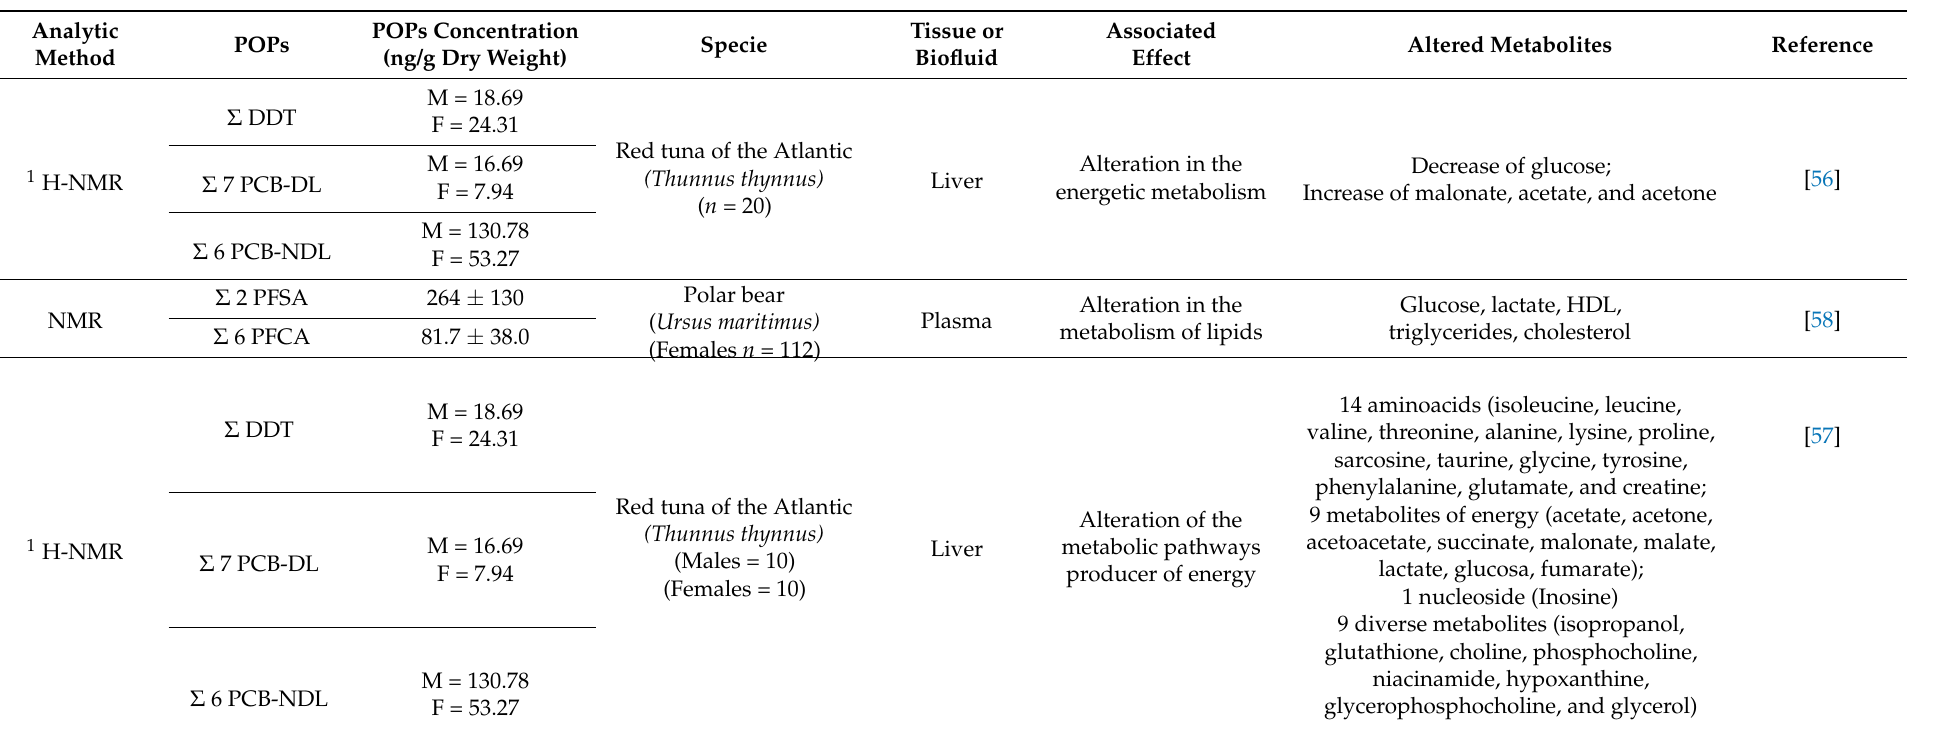
Table 2. Metabolomics studies evaluating the effects of environmental exposure to POPs in